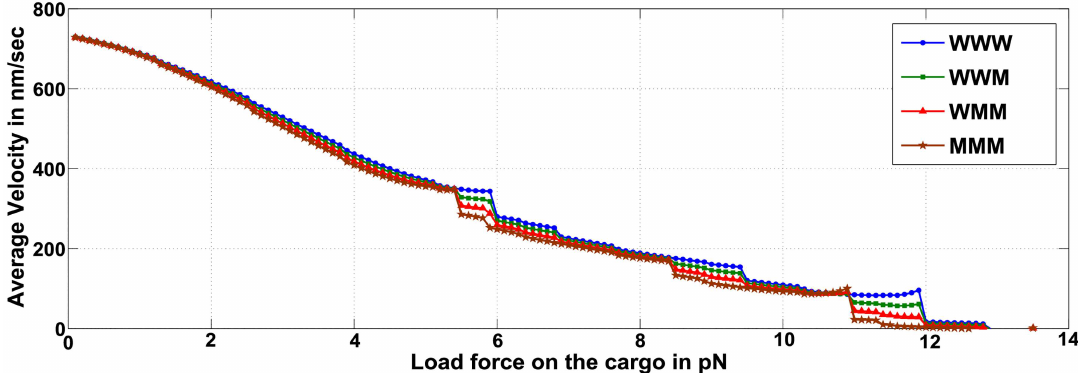
Fig 7. Average velocity with varying load forces on the cargo for ensembles WWW, WWM, WMM and MMM.